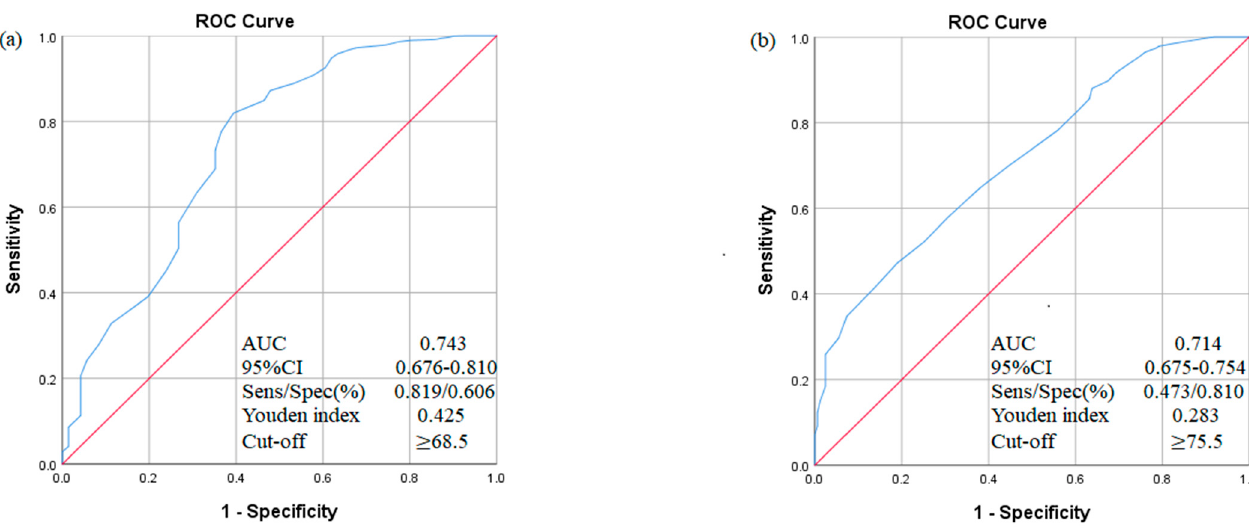
Figure 1. ROC curve for CDGCI-PW score in predicting gestational hypertension ( a ) and GDM ( b ). ROC curve, receiver operating characteristic curve; AUC, area under the ROC curve; CI, confidence interval; Sens, sensitivity; Spec, specificity.